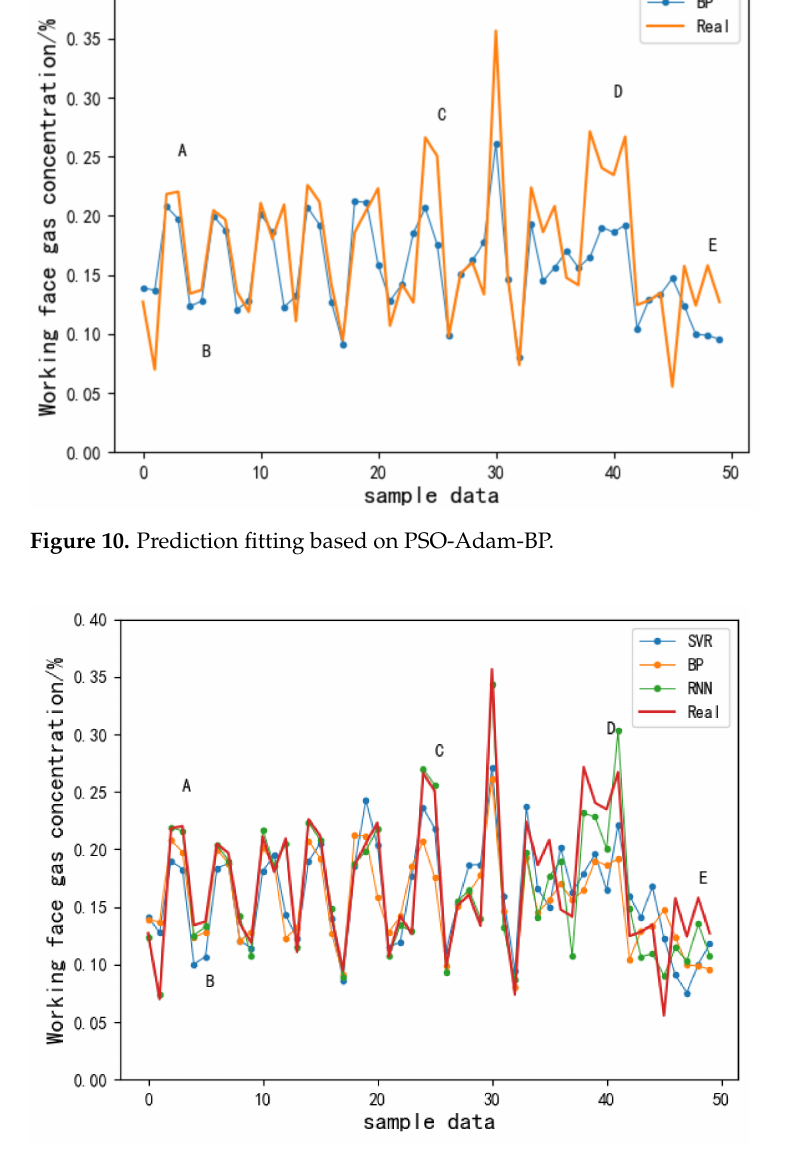
Figure 11. A comparison of the prediction results of the different